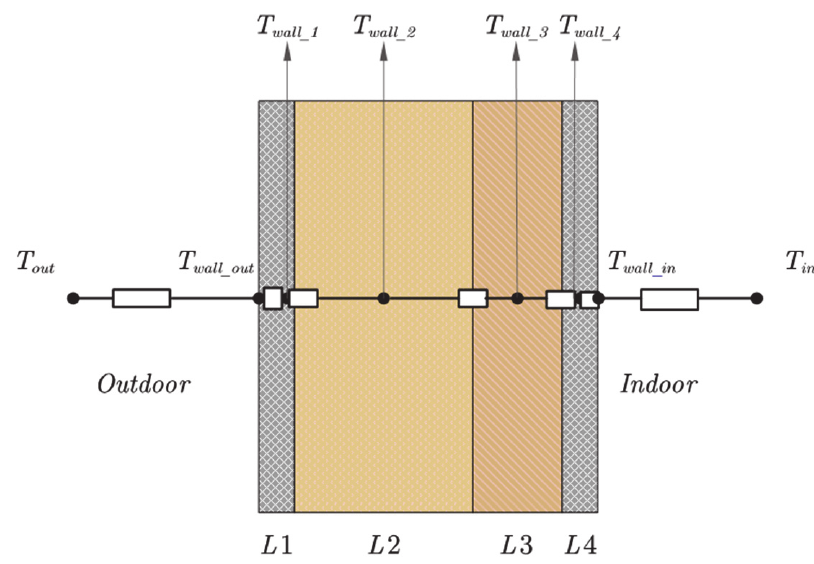
Figure 2. The nodes of external walls.